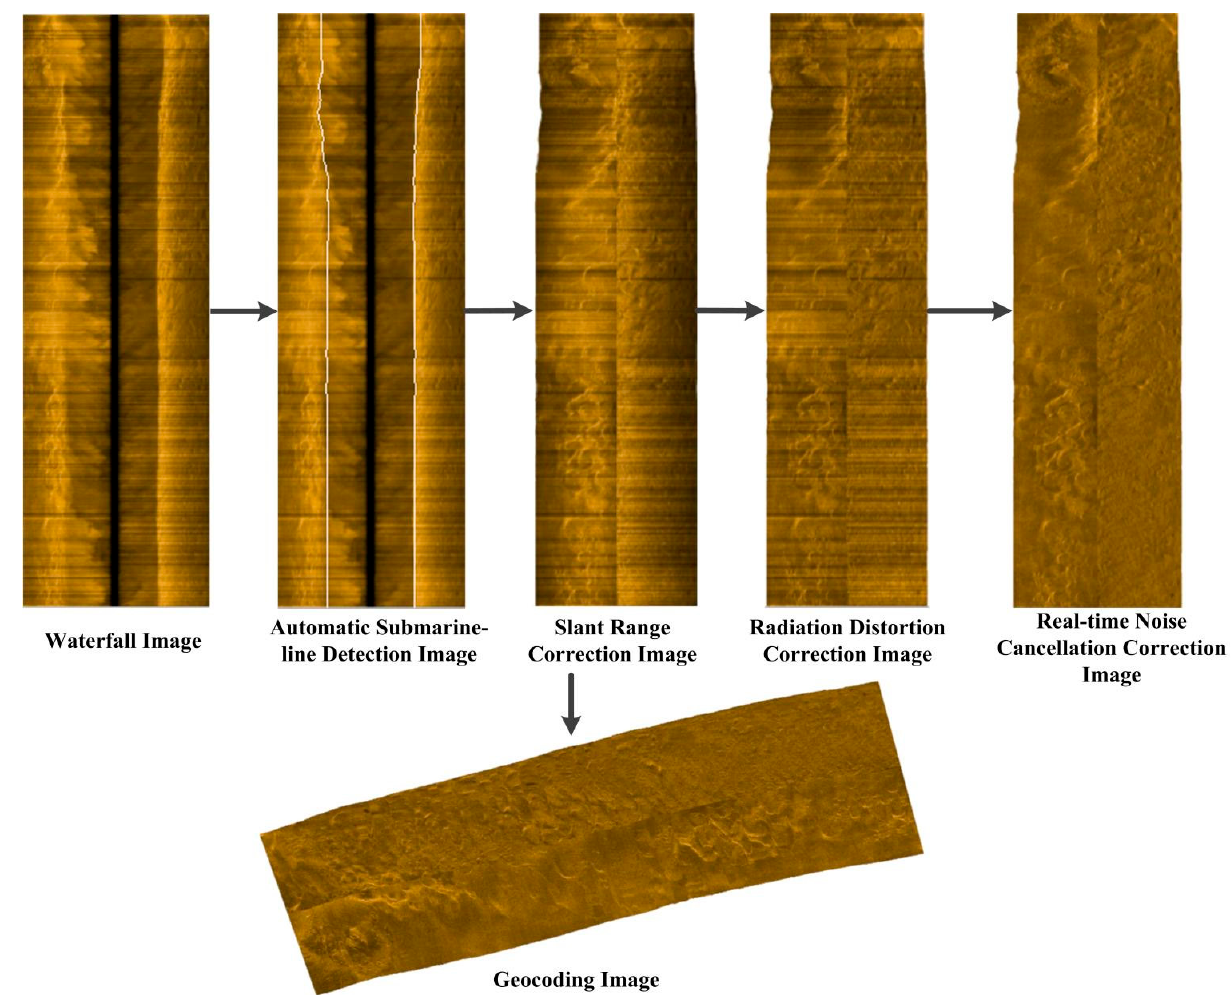
Figure 5. Output images of the main steps of SSS data processing.